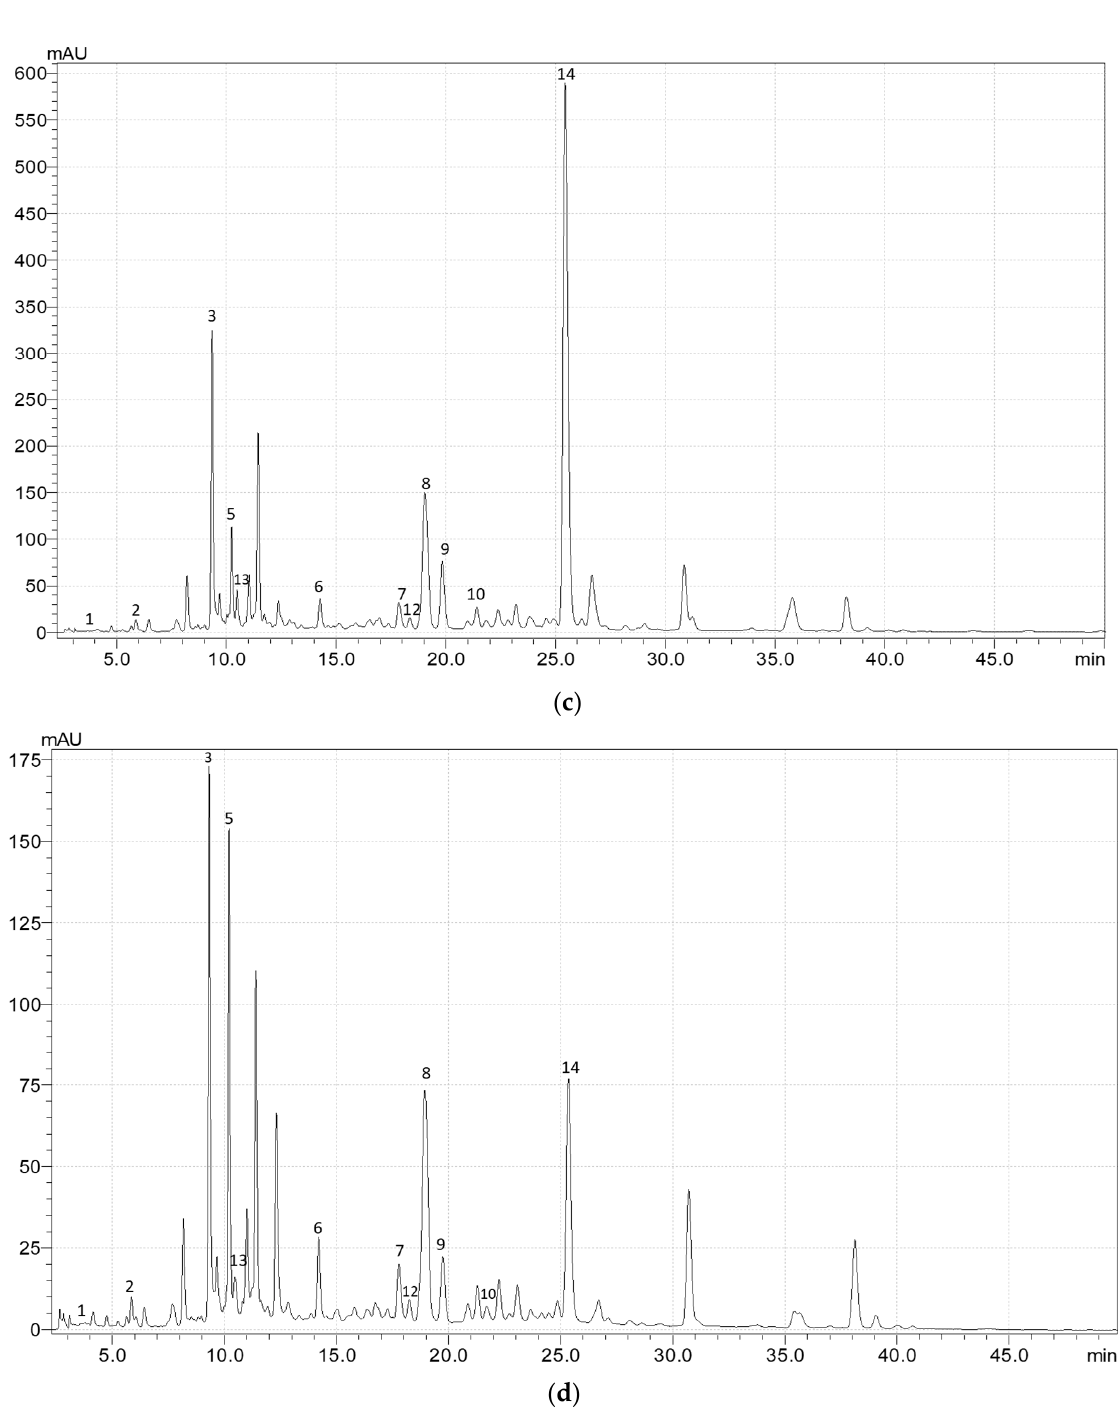
( e ) Figure A1. Exemplary HPLC chromatogram (at 340 nm) of the phenolic acids and flavonoids in ( a ) the upper leaves, ( b ) upper stems, ( c ) flowers, ( d ) fruits, and ( e ) roots of meadowsweet ( Filipendula ulmaria (L.) Maxim.). 1—gallic acid; 2—3,4-dihydroxybenzoic acid; 3—caftaric acid; 4—catechin; 5— chlorogenic acid; 6—p-coumaric acid; 7—ellagic acid; 8—rutin; 9—isoquercitrin; 10—cynaroside; 11—astragalin; 12—salicylic acid; 13—caffeic acid; 14—spiraeoside. References 1. Bespalov, V.G.; Alexandrov, V.A.; Semenov, A.L.; Vysochina, G.I.; Kostikova, V.A.; Baranenko, D.A. The inhibitory effect of Filipendula ulmaria (L.) Maxim. on colorectal carcinogenesis induced in rats by methylnitrosourea. J. Ethnopharmacol. 2018 , 227 , 1–7. https://doi.org/10.1016/j.jep.2018.08.013.